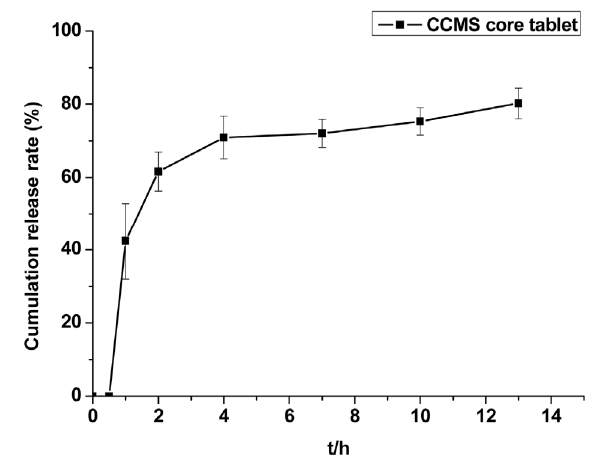
Figure 3. The dissolution property of CAP from the CCMS core tablet. Each point represents the mean ± SD. Abbreviations: CCMS, capsaicin-chitosan microspheres; CAP,